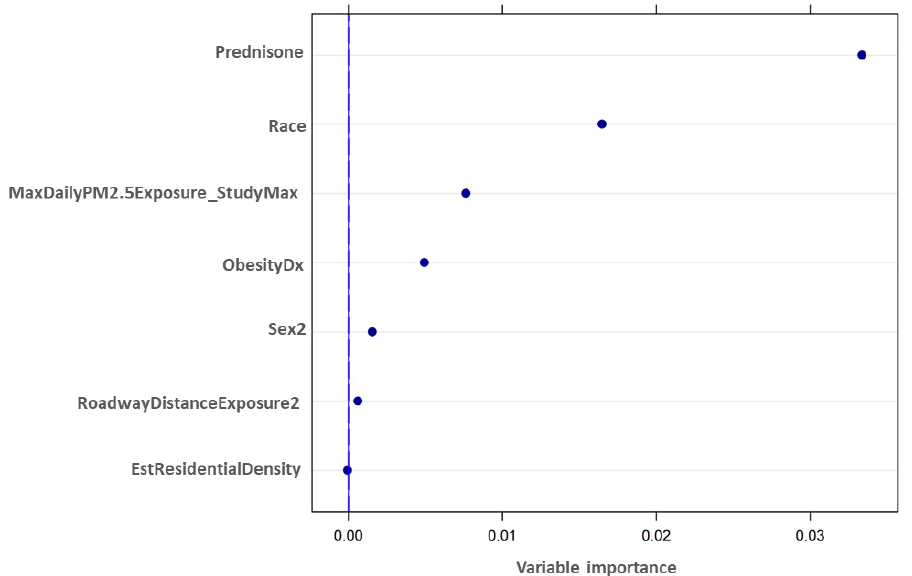
Figure 2. Predictor variable importance, as determined by CRF analysis. The cforest algorithm within Package party in R was applied to the ICEES multivariate dataset (see Figure 1 and Table 1) to determine the most important predictor variables in relation to the dependent variable of total annual ED or inpatient visits for respiratory issues. The vertical dashed line represents the significance threshold; values to the right of the line are significant. Variables are defined in Table 1.